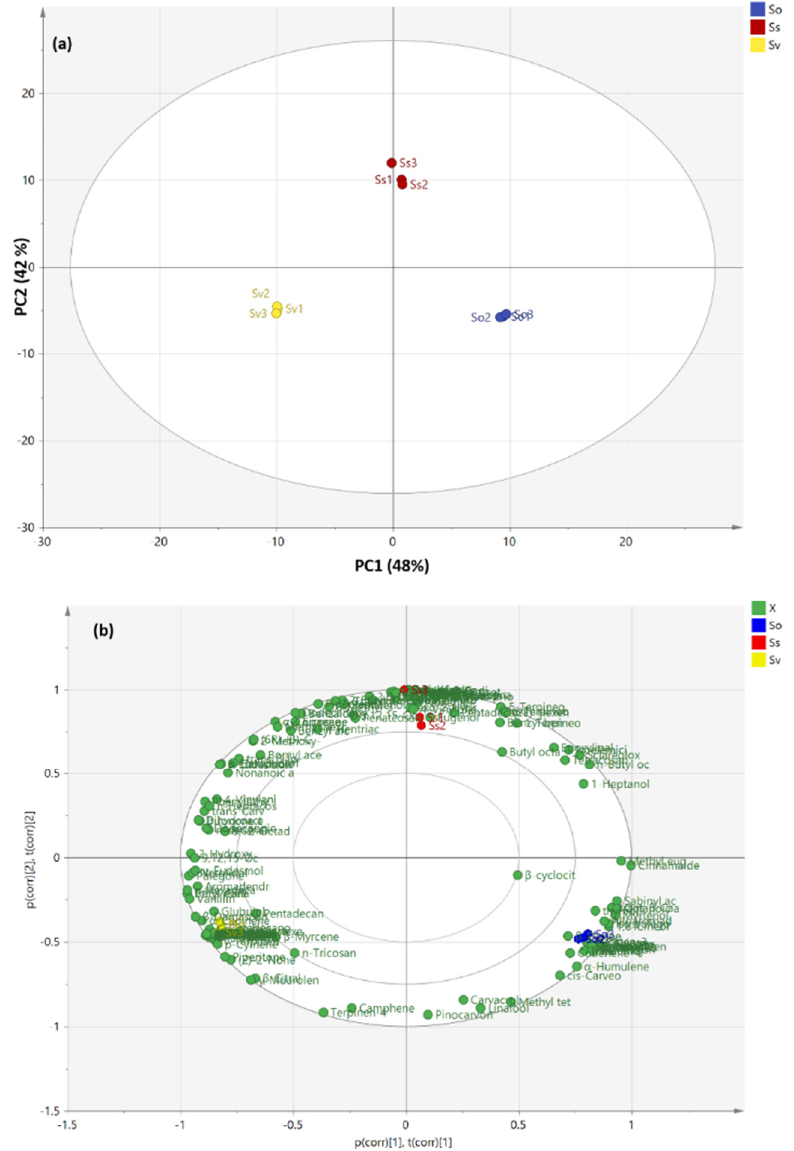
Figure 1. PCA score plot: ( a ) biplot; ( b ) based on GC-MS chemical profile of the essential oils of different Salvia species as displayed in Table 1. S. officinalis (So), S. virgata (Sv) and S. sclarea (Ss). Additionally, HCA was applied as an unsupervised pattern recognition method to support results obtained by PCA. Figure 2 shows the HCA dendrogram, which displays segregation of different Salvia species in three main clusters. Cluster I, II and III present S. virgata (Sv), S. officinalis (So) and S. sclarea (Ss), respectively. The HCA dendrogram reveals the closeness of S. officinalis (So) and S. sclarea (Ss). HCA results endorse that of PCA.